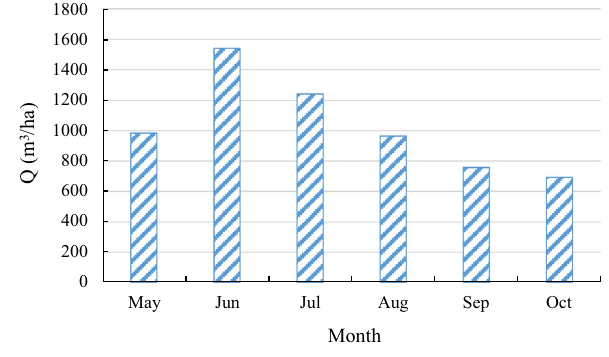
Fig. 2 Average monthly irrigation water demand